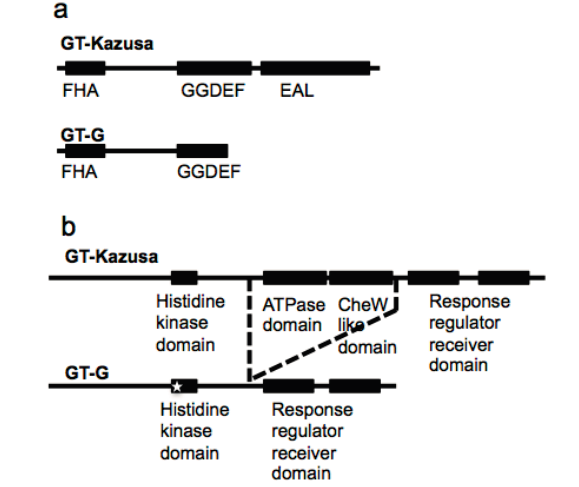
Figure 1. Domain organization of mutated genes coding protein in GT-Kazusa and GT-G. The black box indicates the conserved motif. ( a ) Domain organization of Sll1895. FHA: Forkhead-associated domain for phosphopeptide recognition; GGDEF: diguanylate cyclase domain; EAL: candidate for a diguanylate phosphodiesterase function. Sll1895 in GT-G loses EAL domain and part of the GGDEF domain; ( b ) Domain organization of